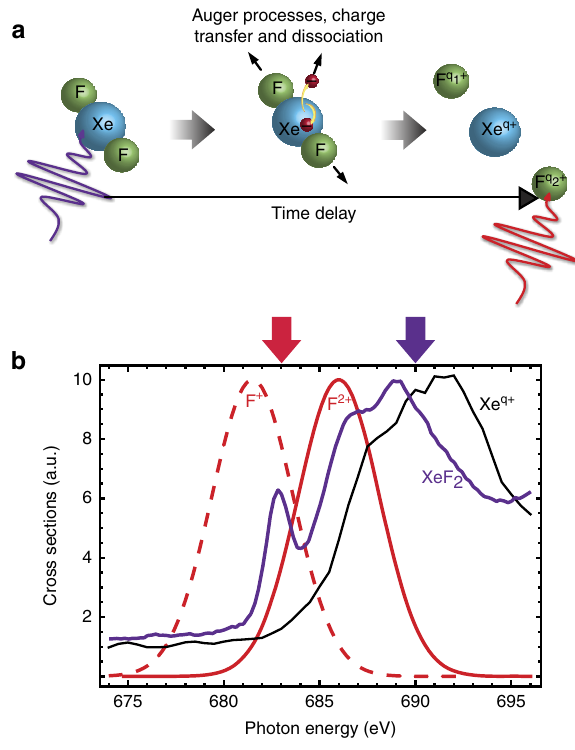
Figure 2 | Hetero-site X-ray pump-probe scheme for xenon difluoride. ( a ) Sketch of the two-colour X-ray-pump/X-ray-probe scheme used for studying the molecular fragmentation of XeF 2 . A 690-eVpump pulse excites the Xe 3 d - e F shape resonance and triggers core-hole decay. In the core-hole decay, several nonradiative electronic processes such as Auger decay participate, emitting valence electrons and leaving a highly charged molecule. The induced dynamics leads to fragmentation of the molecule into three separated ions, F q 1 þ (cid:2) Xe q þ (cid:2) F q 2 þ . In our experiment, after time delays of 4, 29 and 54fs, a 683-eV probe pulse excites the 1 s - 2 p resonances of F þ or F 2 þ as the molecule dissociates. ( b ) Photoabsorption cross-sections for the pump (purple arrow) and probe (red arrow) pulses. The cross-sections are arbitrarily scaled. Neutral XeF 2 cross-sections (purple line) are taken from ref. 22, xenon ions Xe q þ cross-section (black line) are taken from ref. 30 and averaged over q þ using the ion-branching ratios of ref. 22, and atomic F 1 s - 2 p resonances of F þ or F 2 þ (red lines) are calculated with Cowan’s code 31,32 . Cross-sections have been broadened to account for the B 5-eV widths of the B 10-fs pulses. The two-colour pulses excite the molecule at the Xe site and probe the F ions formed during